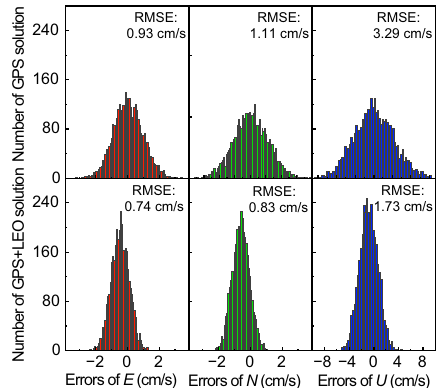
Fig. 7 Error distribution of GPS and GPS determination, and corresponding RMSEs in the east (E), north (N), and up (U) directions at station SCOR